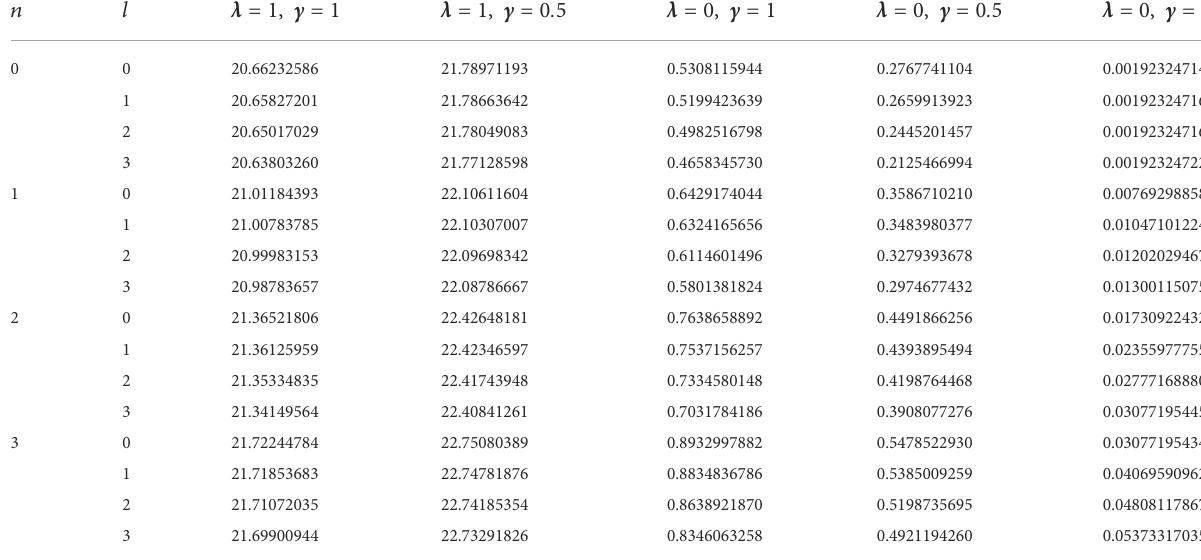
TABLE 3 Energy eigenvalues (− E nl ( eV )) of the shifted screened Kratzer potential for LiH .